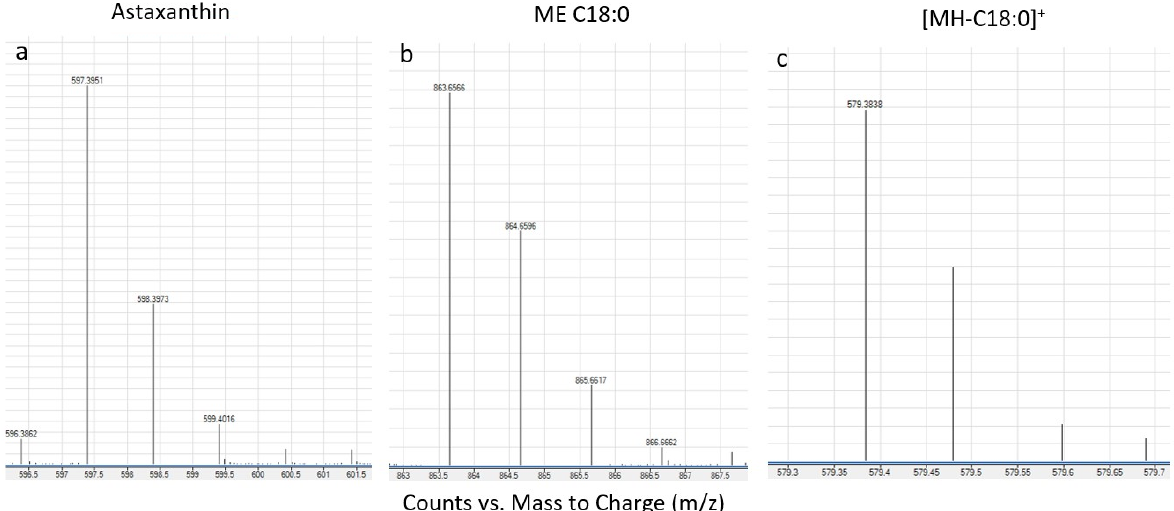
Figure 1. LC-QTOF-MS mass spectra (ESI, positive ion mode) of ( a ) astaxanthin, ( b ) astaxanthin monoester [ME C18:0] and ( c ) m/z 579.3840 [MH-C18:0]+.